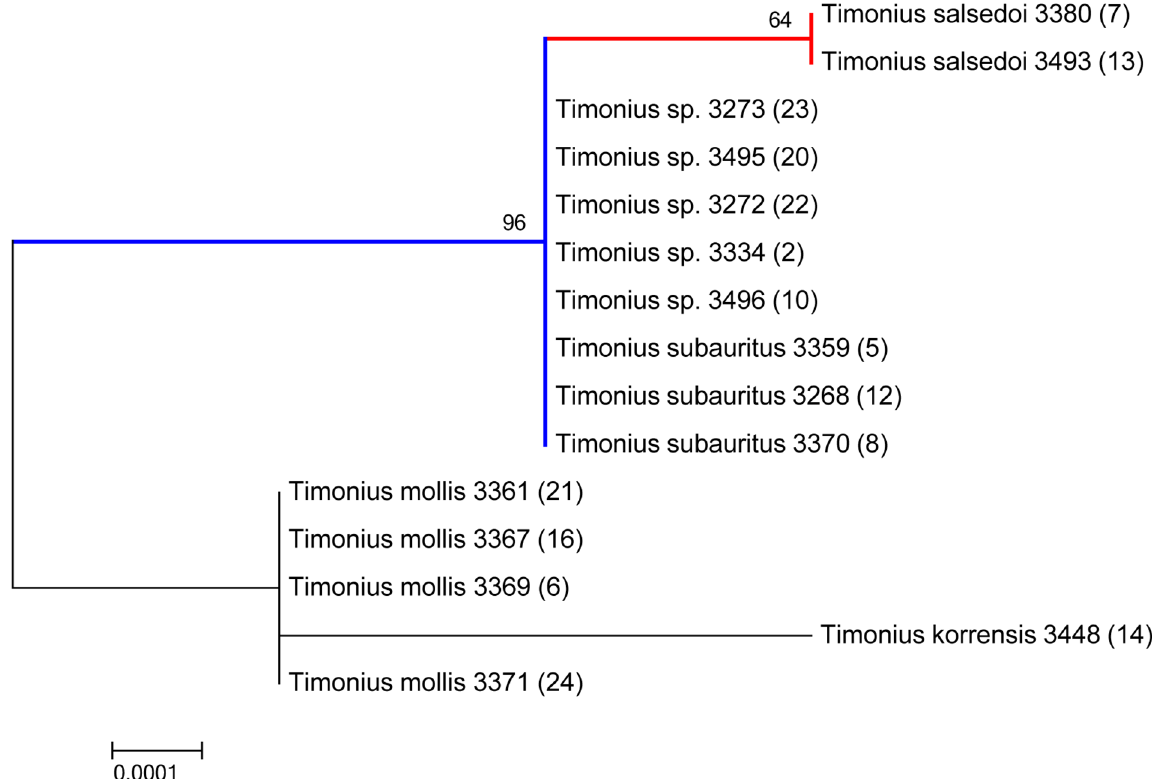
Fig 3. Maximum likelihood tree from seven-locus DNA barcode alignment ( rbcL , matK , ITS , trnH-psbA , trnL-trnF , petD , atpB-rbcL ) with bootstrap support values at branch nodes and species followed by collection number (DNA sample number) at the branch tips. The tree with the highest likelihood (-4639.8901) is shown and drawn to scale, with branch lengths proportional to the number of substitutions per site.